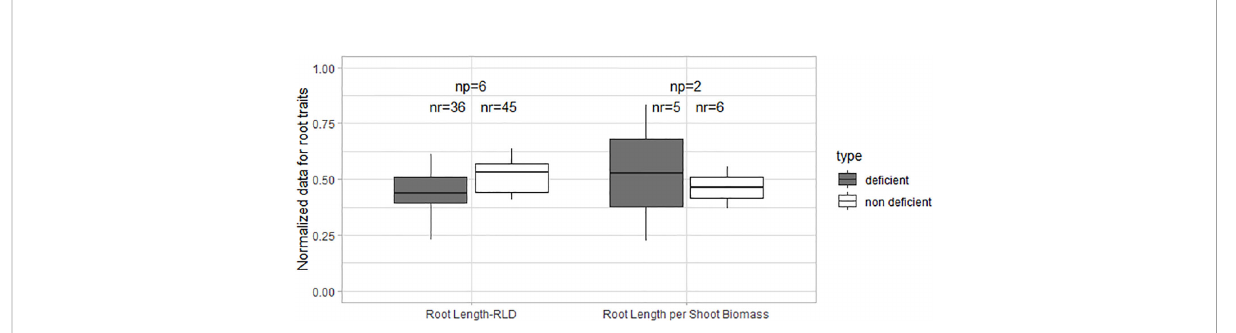
FIGURE 4 Boxplot of the normalized root data under K de fi ciency and K non-de fi ciency. A t-test was performed; no signi fi cant differences were found. np stands for the number of publications/studies considered in the calculation and nr the total number of observations within these publications